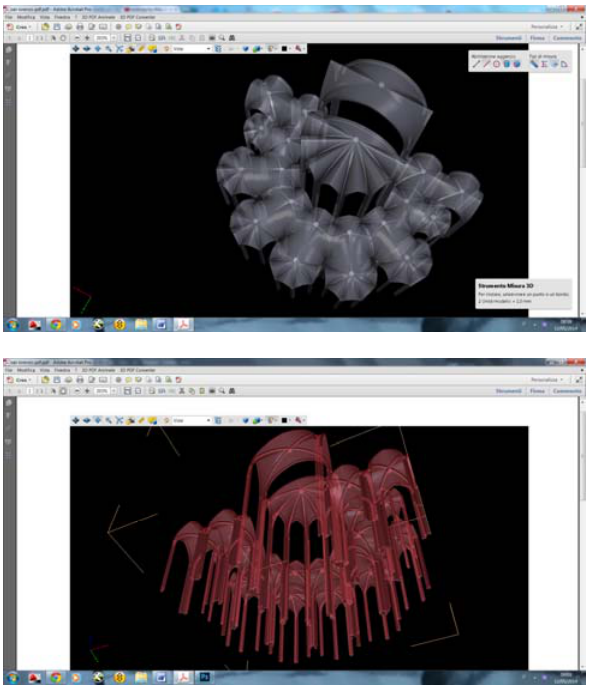
Figure 12. Naples S. Lorenzo Maggiore. 3D PDF: a tool to spread knowledge.